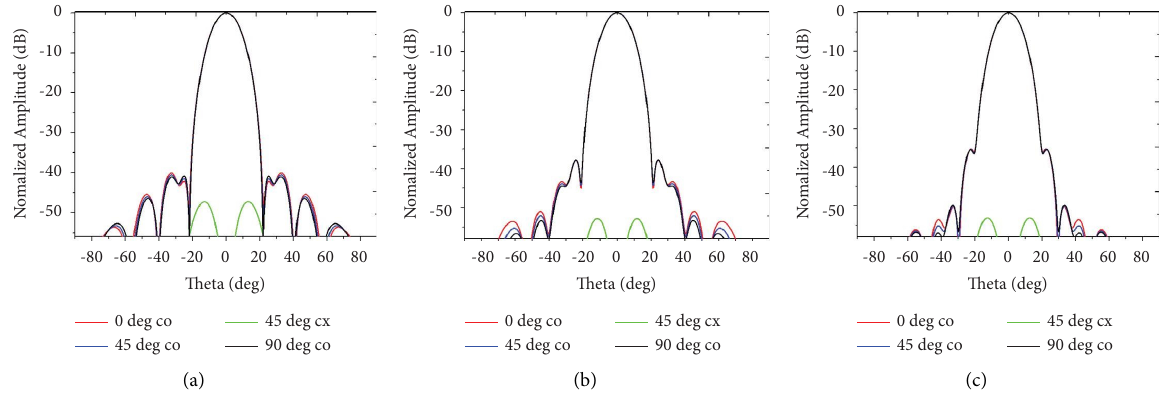
Figure 4: Ultra-Gaussian corrugated horn feed radiation pattern. (a) 100GHz, (b) 300GHz, and (c) 500GHz.